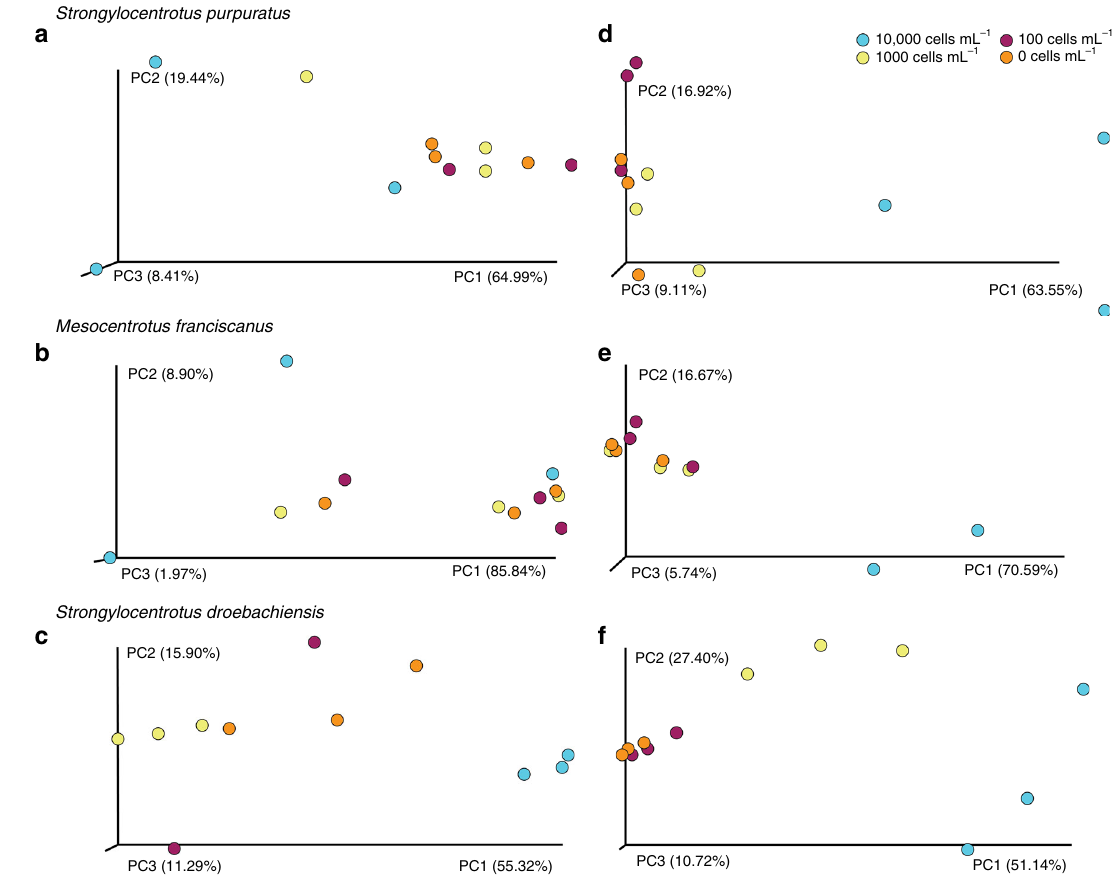
Fig. 4 Induction of differential associations in the microbial community based on feeding environment for three species of echinoid larvae. Community similarity of the associated microbiota for Strongylocentrotus purpuratus ( a , d ), Mesocentrotus franciscanus ( b , e ), and S. droebachiensis ( c , f ) prior to ( a – c ) and post ( d – f ) expression of phenotypic plasticity, with larvae having been fed 10,000 (blue), 1000 (yellow), 100 (maroon), or 0 cells mL − 1